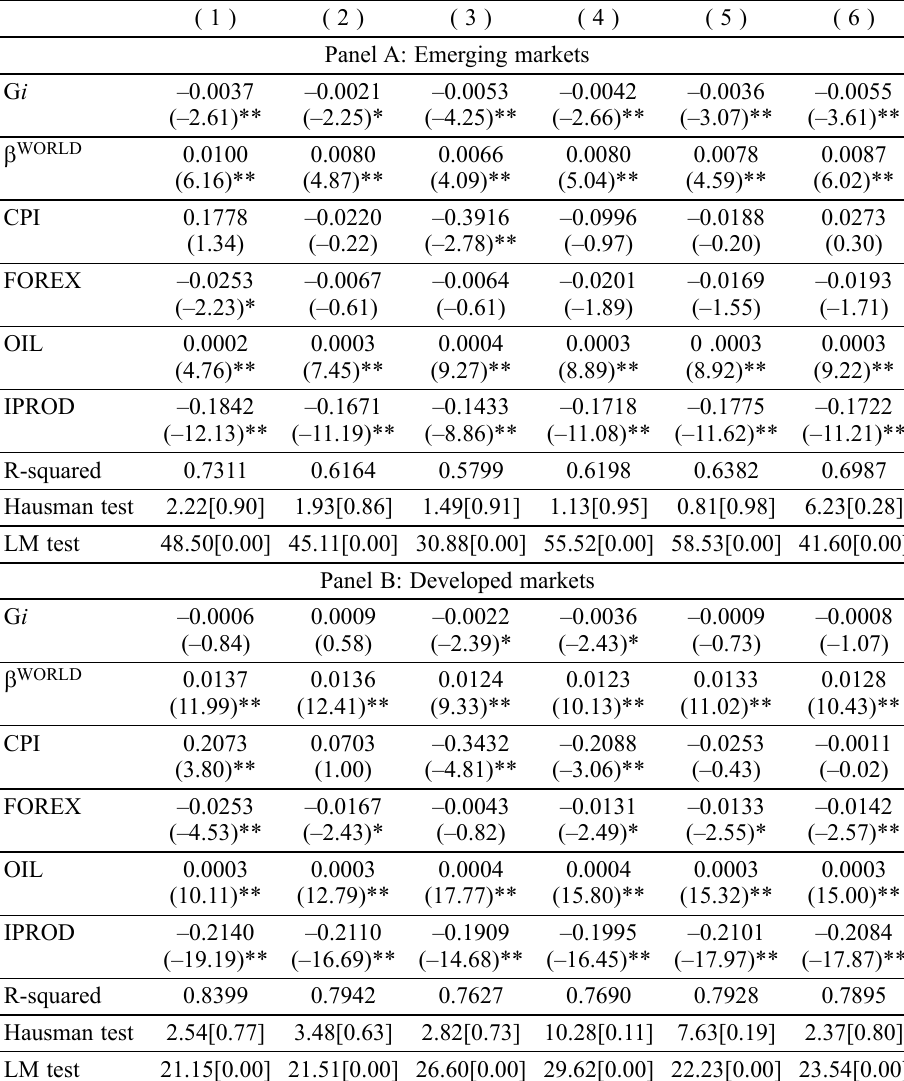
Table 4. Panel regression of equity market risk on governance variables and global risk factors